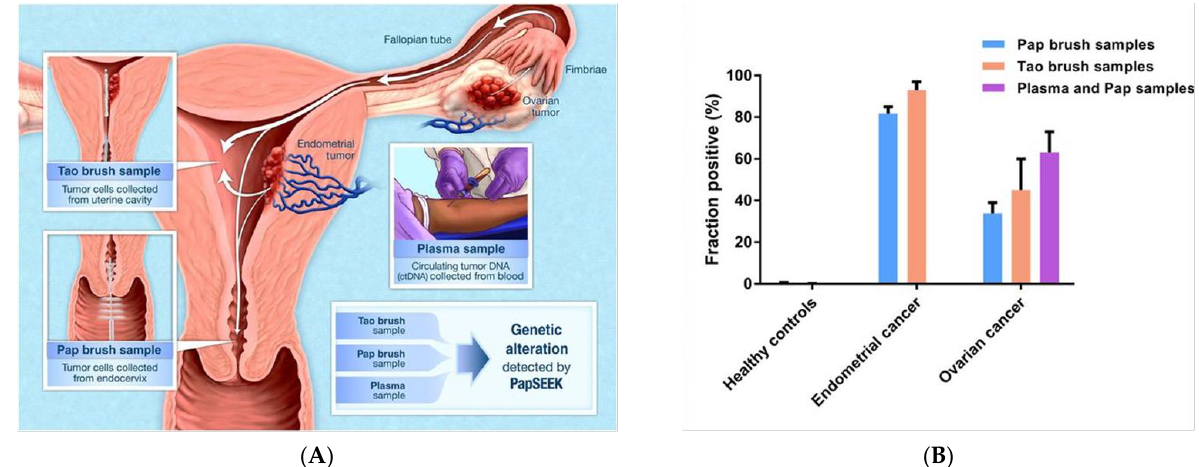
Figure 7. PapSEEK, proposed by Wang et al. [90], ( A ) DNA extracted from patient cytologic fluids and plasma is assayed for genetic alterations. ( B ) Target genes assayed for mutations were found in cytologic fluid for endometrial cancer samples and in both cytologic fluids and plasma for ovarian cancer samples but not in healthy controls. Used with permission.